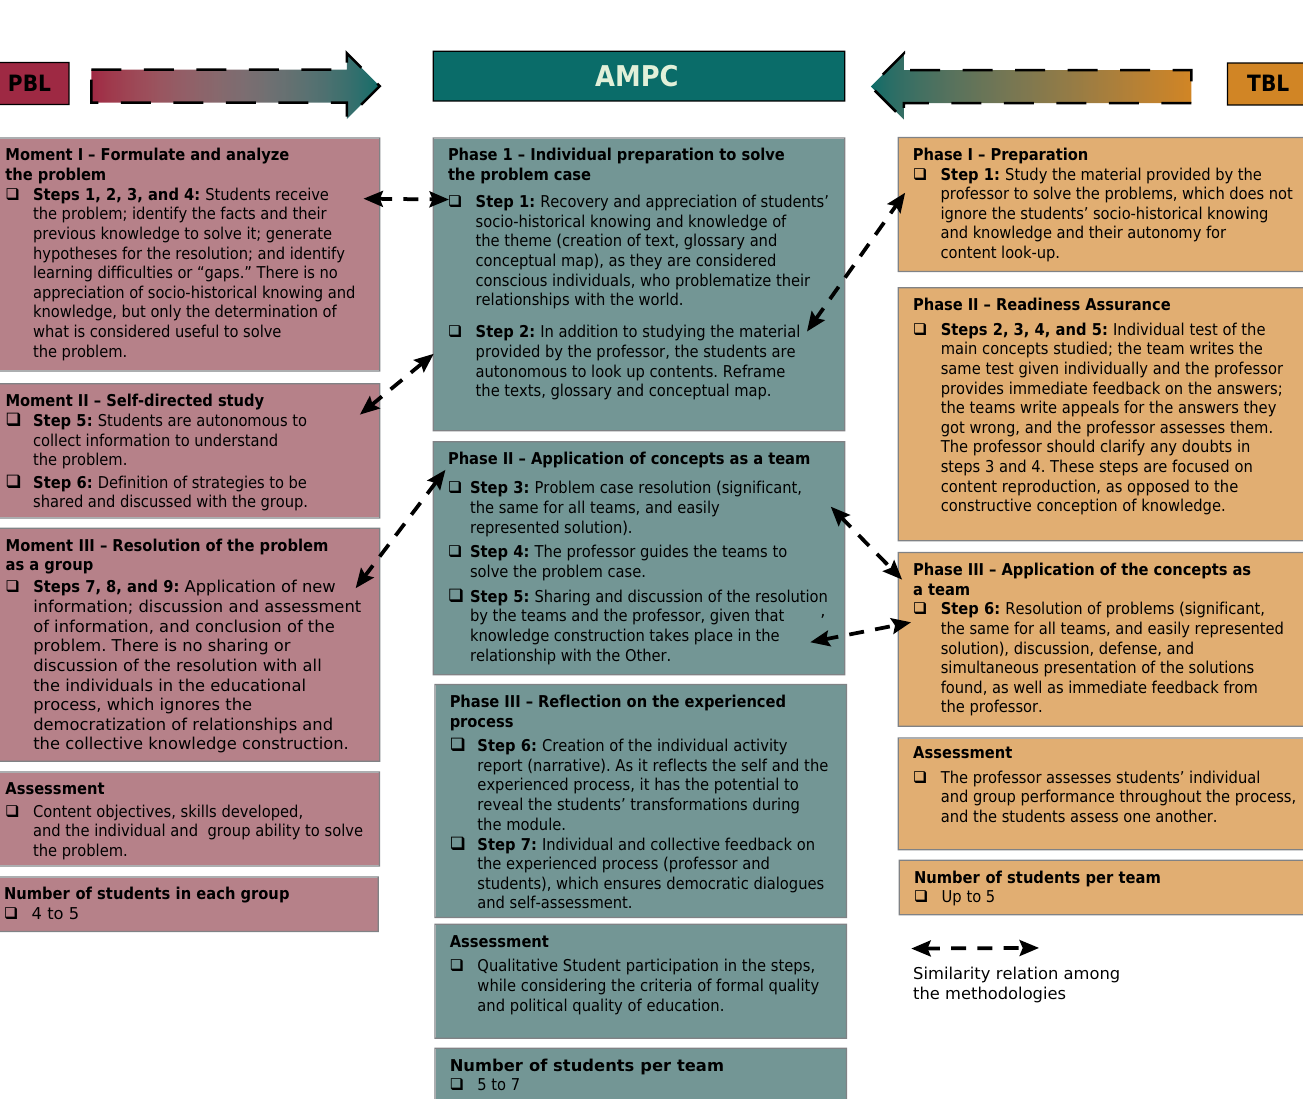
Figure 2. Synthesis of moments, steps, and stages of the Problem-Based Learning (PBL) methodologies as modified and presented by Lopes et al. (2019), Team-Based Learning (TBL), as presented by Michaelsen and Sweet (2008), and the Alternative Methodology of Problem Cases (AMPC), identifying the similarities between PBL and TBL concerning the